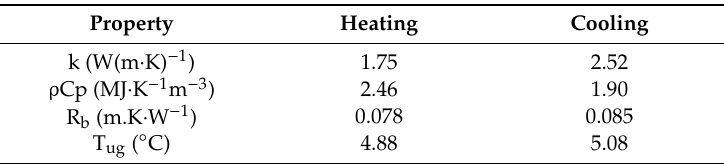
Table 5. Calibrated model parameters.